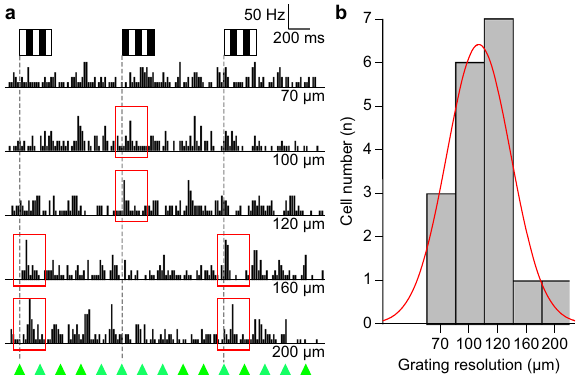
Fig. 8 Spatial resolution limit. a Peri-stimulus time histograms (bins of 10 ms) for one RGC upon grating pattern reversal stimulation with decreasing bar widths (200, 160, 120, 100 and 70 µ m). A grating pattern with black and green vertical bars (560 nm, 10 ms, 0.9 mW mm − 2 ) was projected onto the array with a 5-Hz illumination rate for 3 s and reverted every fi ve pulses. The fi rst pattern and the reversals are highlighted by the grey dashed lines. The green triangles correspond to the onset of each light pulse. The red rectangles highlight ML activity. b Distribution of grating resolutions obtained in 18 RGCs.